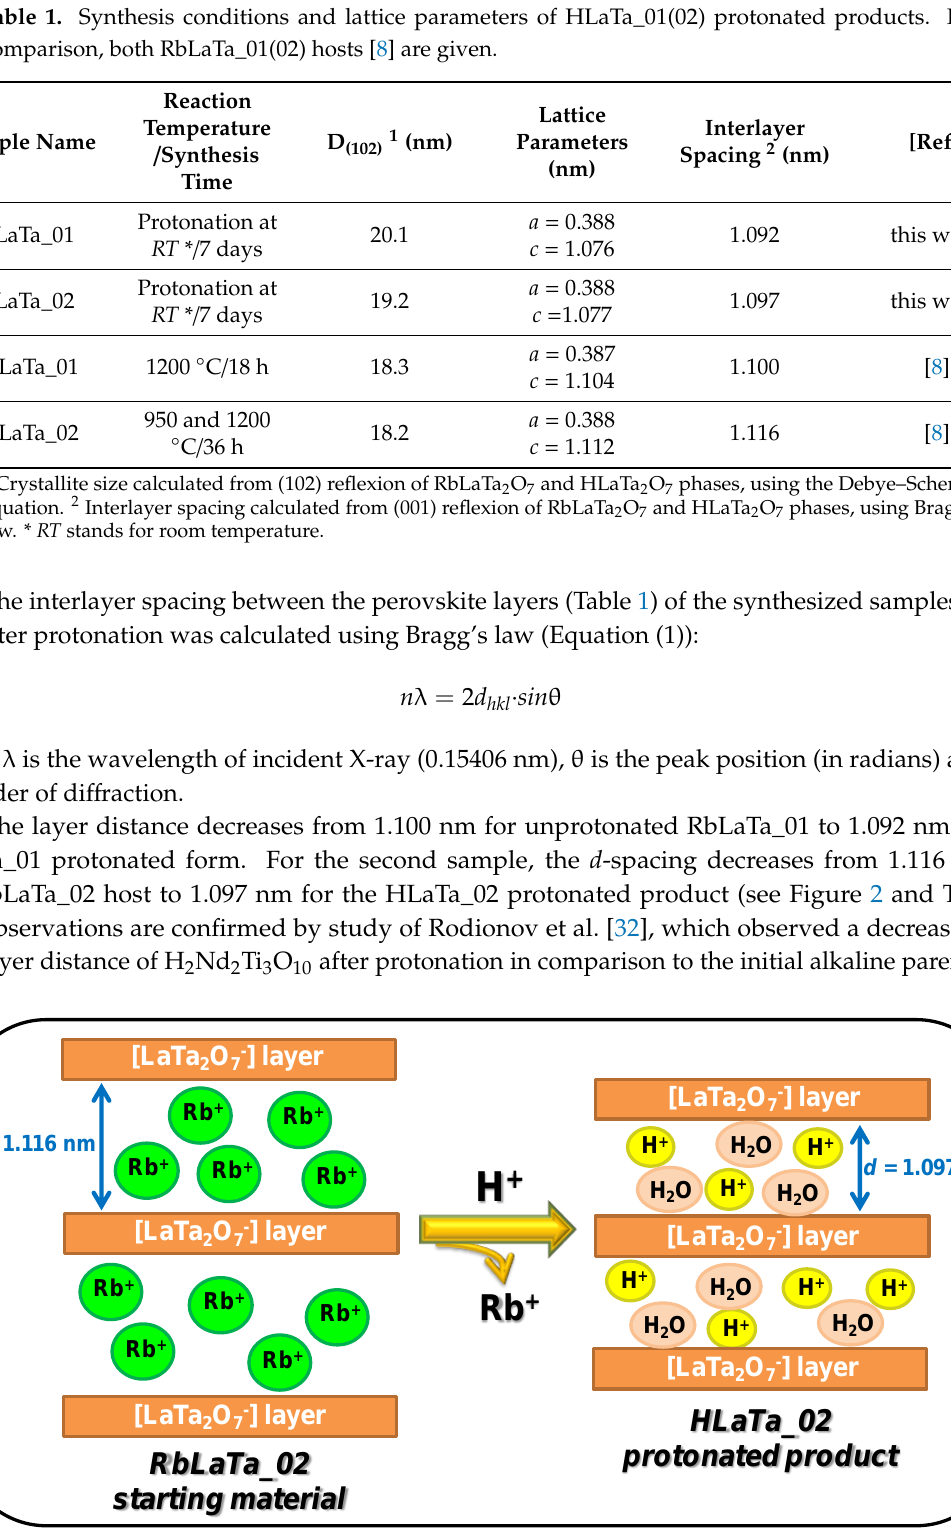
Figure 2. Schematic representation of the alkali cation-proton exchange process over RbLaTa_02 starting material yielding HLaTa_02 product.